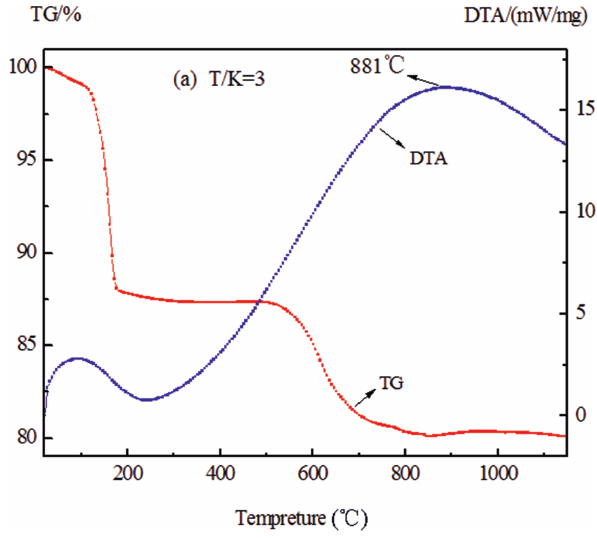
Figure 2: TG – DTA curves of mixture.